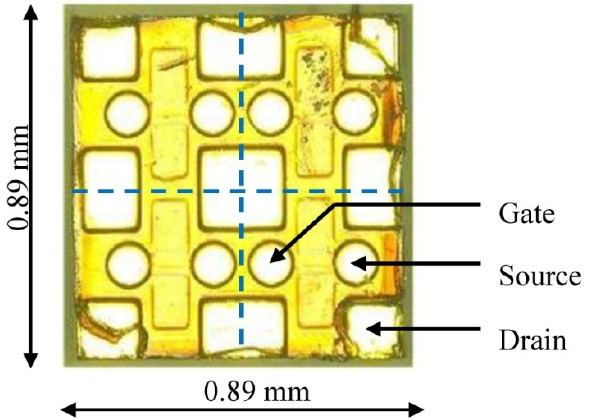
Figure 3. A custom-built SiC VJFET specifically designed for low power RF applications.